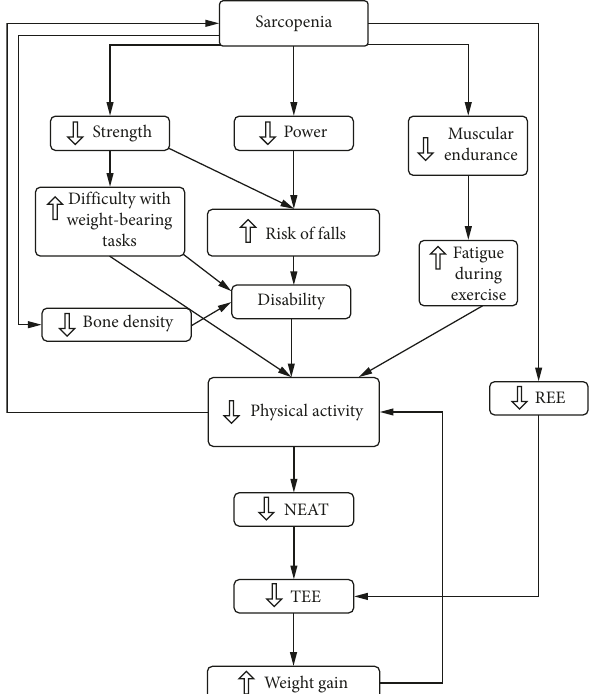
Figure 1: Model describing how sarcopenia affects NEAT and weight